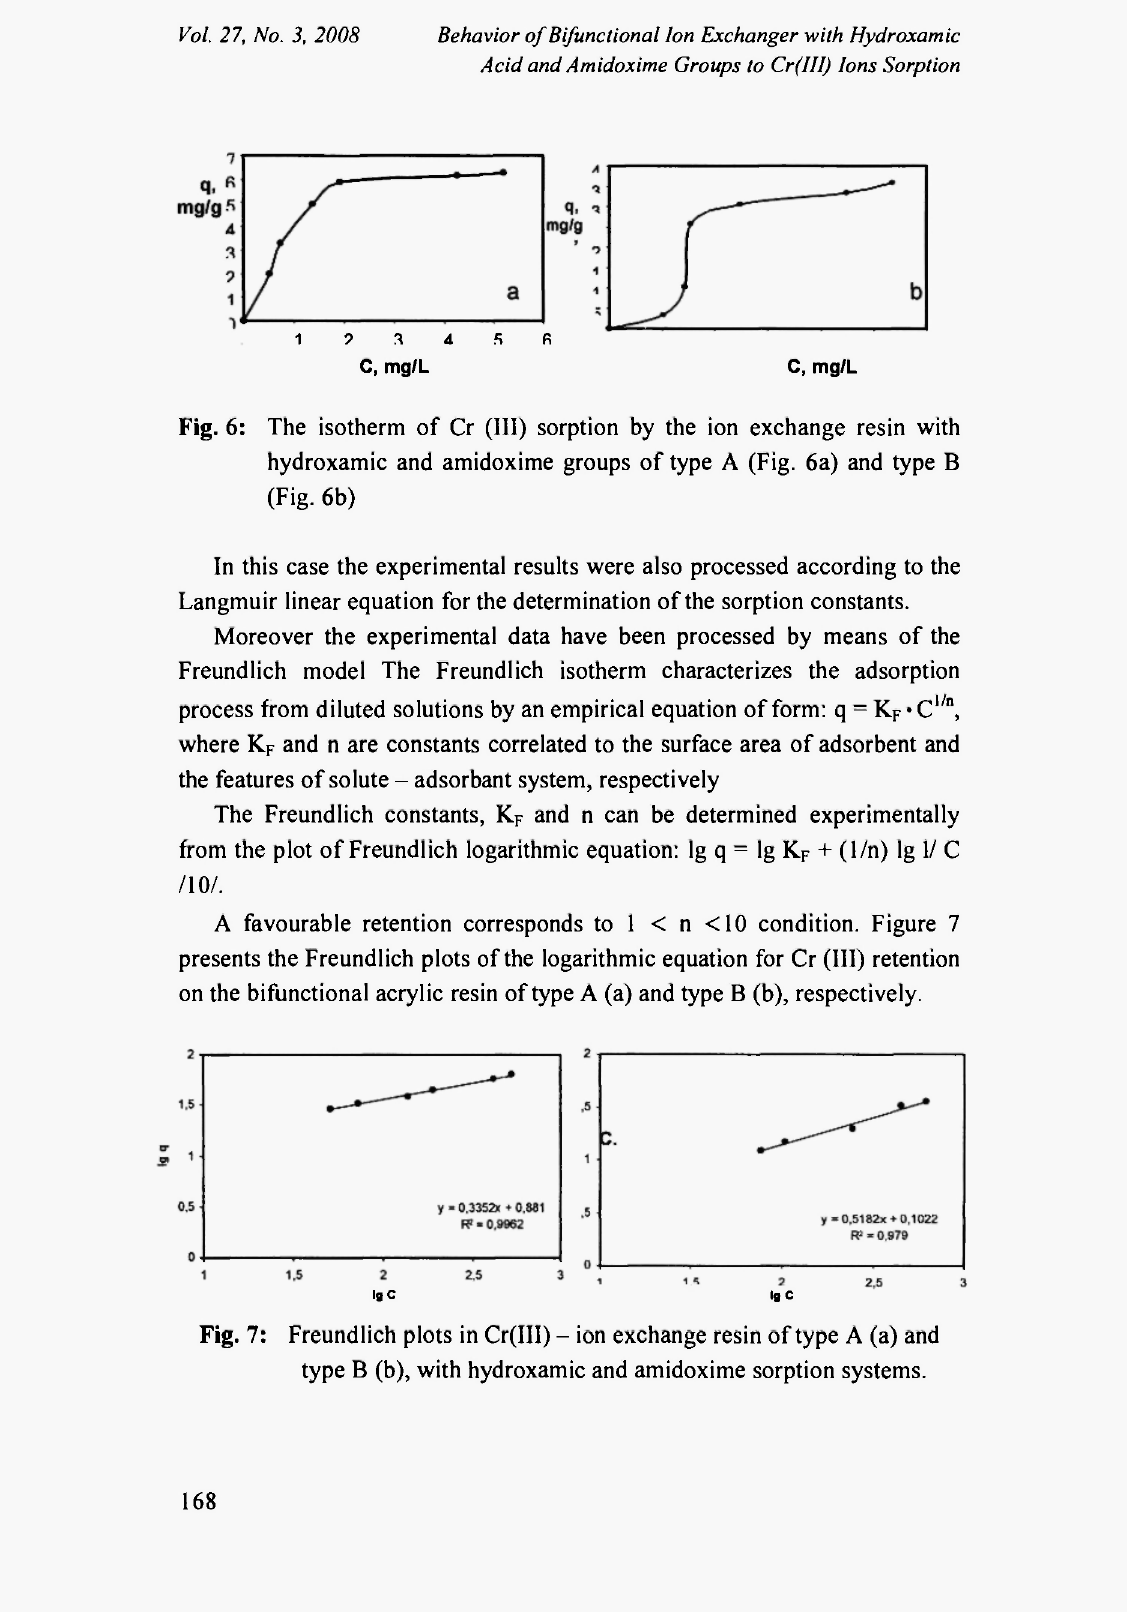
Fig. 6: The isotherm of Cr (III) sorption by the ion exchange resin with hydroxamic and amidoxime groups of type A (Fig. 6a) and type Β (Fig. 6b)